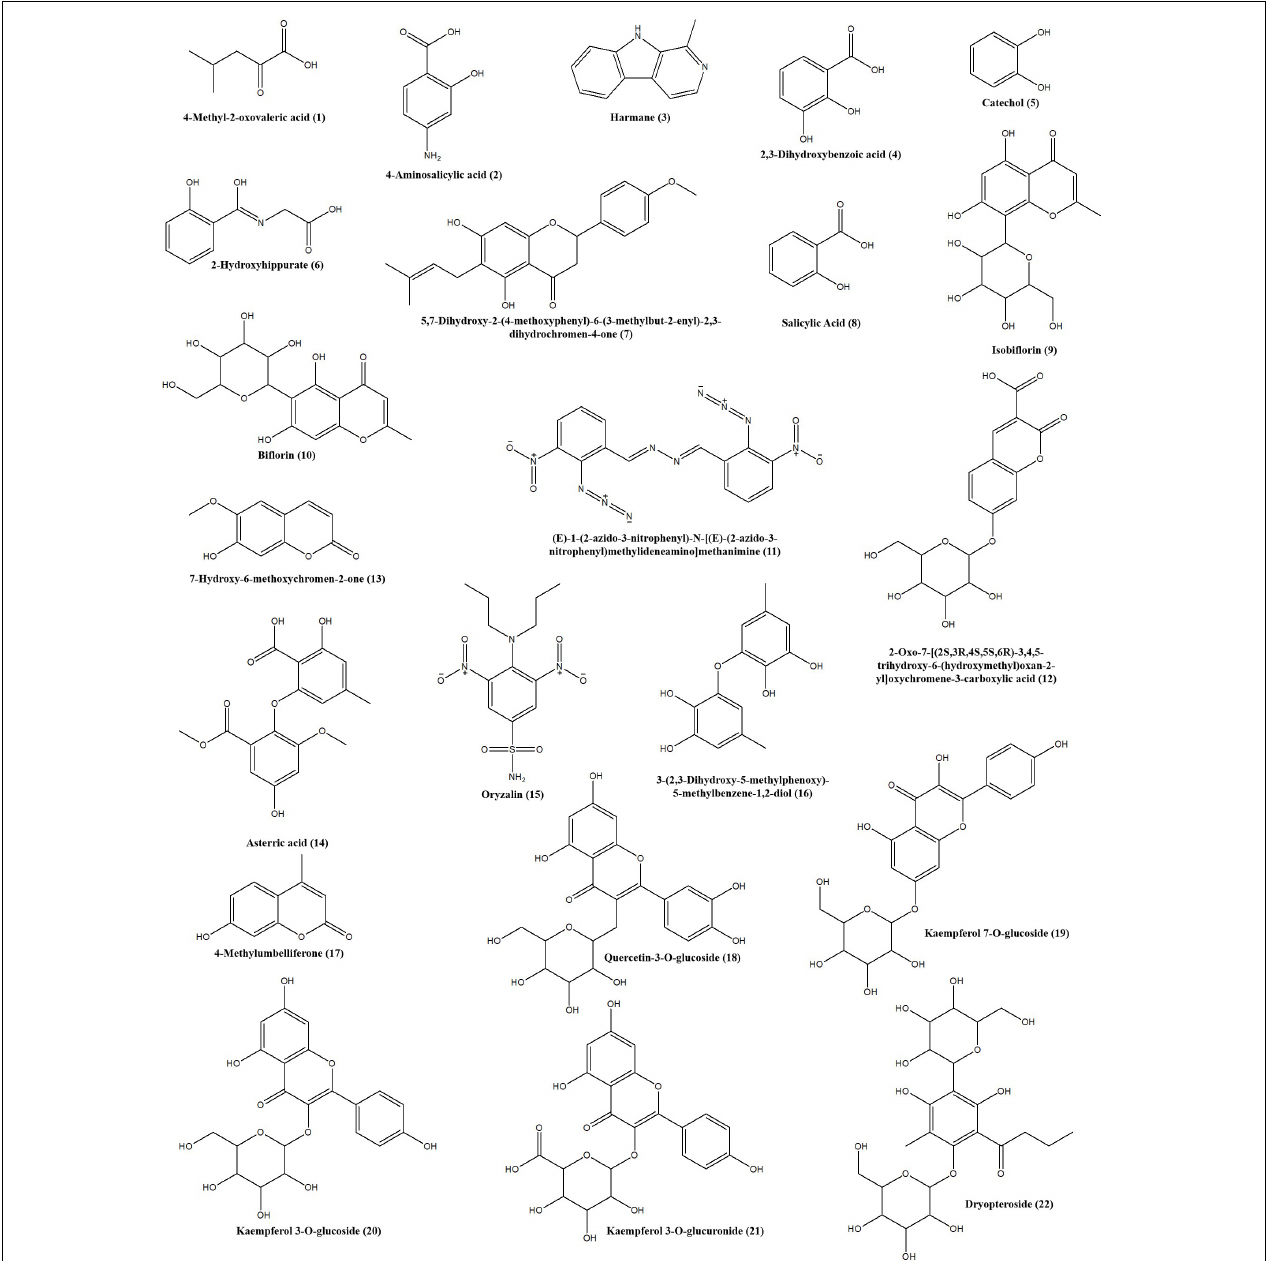
FIGURE 8 | Structures of the tyrosinase inhibitors in the Dryopteris crassirhizoma rhizome (DCR)